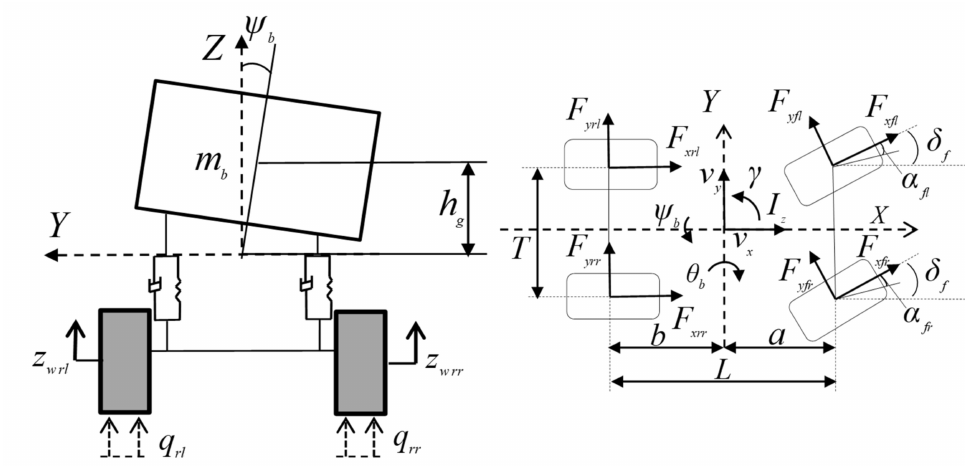
Figure 2. Vehicle dynamics